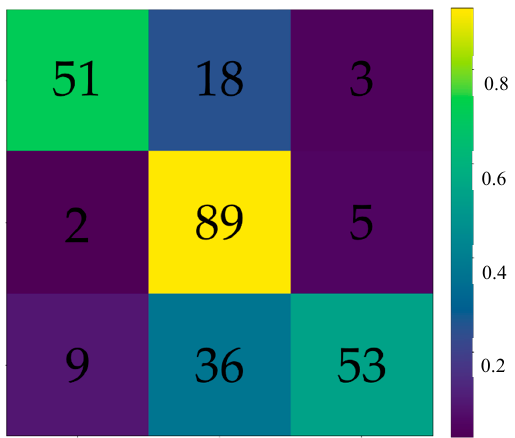
Figure 5. Confusion matrix that describes the performance of the classification model on the test set. The rows of the confusion matrix correspond to the true labels and the columns to the predicted labels. The number of rows and column is equal to the number of the classes.